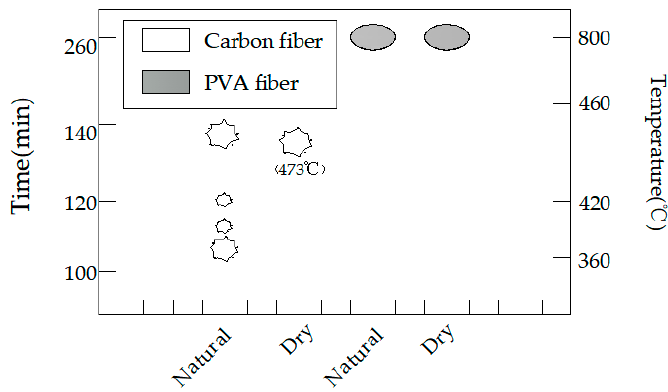
Figure 9. The burst statistics of concrete with different water contents.